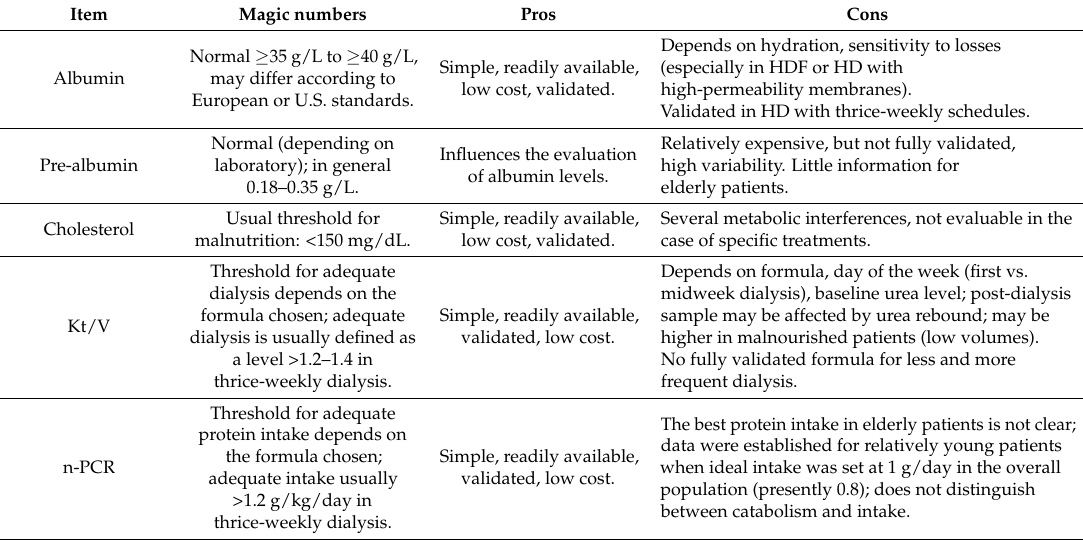
Table 1. “Magic numbers” employed in nutritional evaluation and dialysis prescriptions and their limits: some laboratory